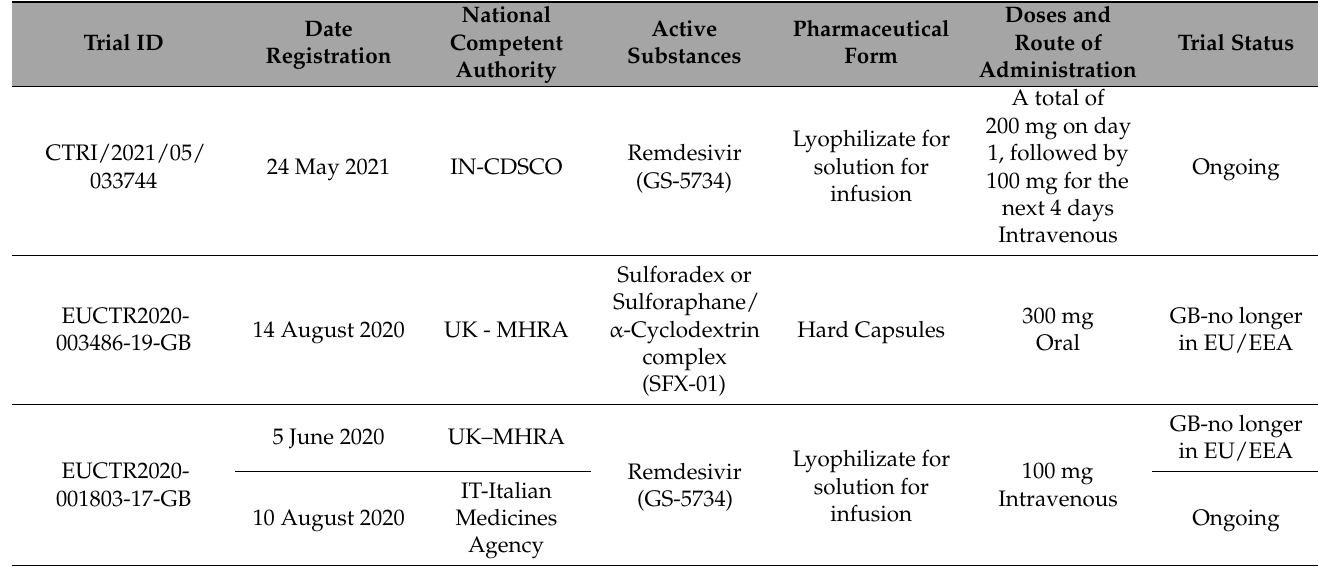
Table 8. Summary of clinical trials involving cyclodextrins for the treatment of